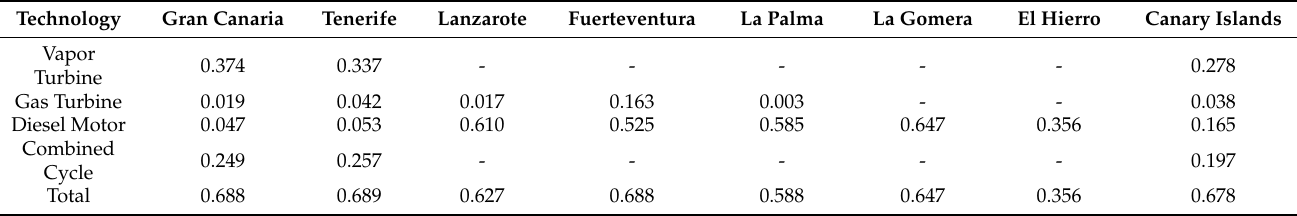
Table 15. Factor Mix according to the technological structure of the generation park that uses oil products in the Canary Islands and broken down by islands. Year 2017.